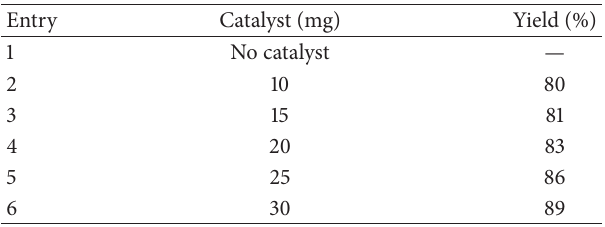
Table 3: Optimization of the ZnO nanoparticle catalyzed model reaction for synthesis of 7 󸀠 -amino-2 󸀠 2 󸀠 -dimethyl-2,4 󸀠 -dioxo- 1,2-dihydrospiro[indoline-3,5 󸀠 -pyrano[2,3-d][1 󸀠 ,3 󸀠 ]dioxine]-6 󸀠